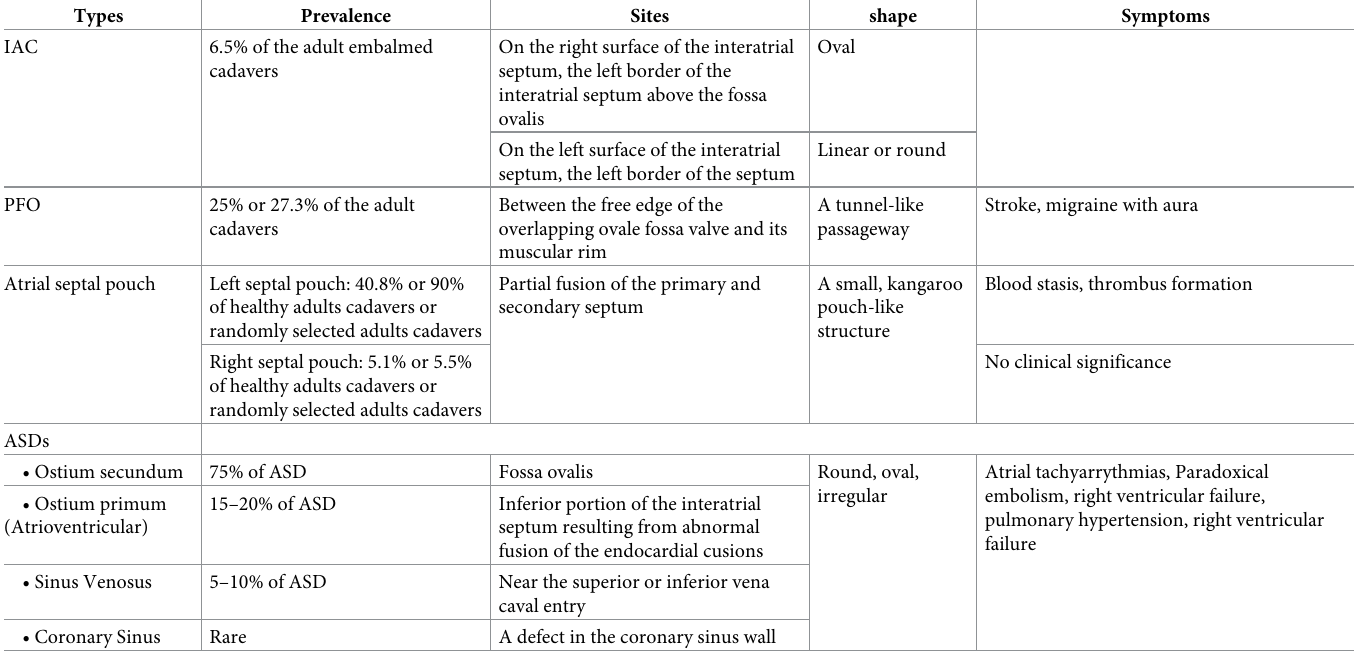
Table 2. Variants of interatrial